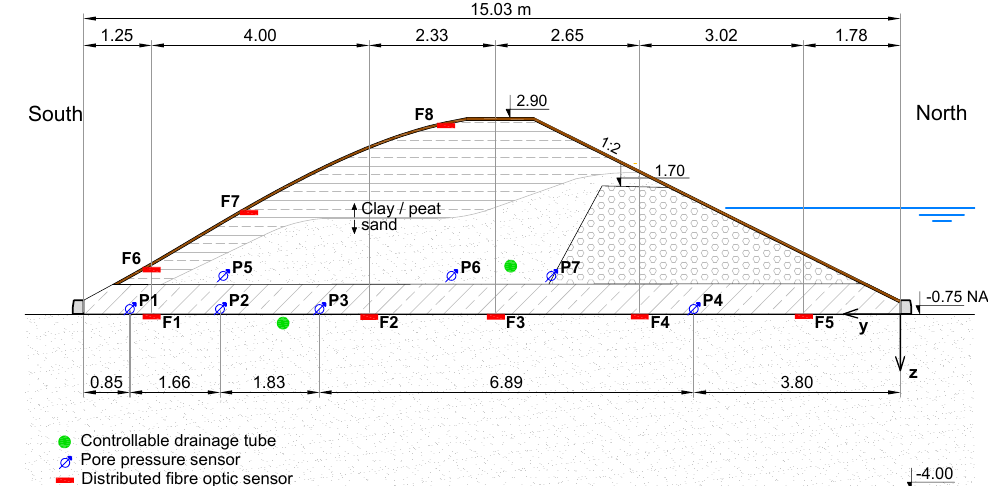
Figure 3. Cross section of the test dike indicating the position of the sensors.